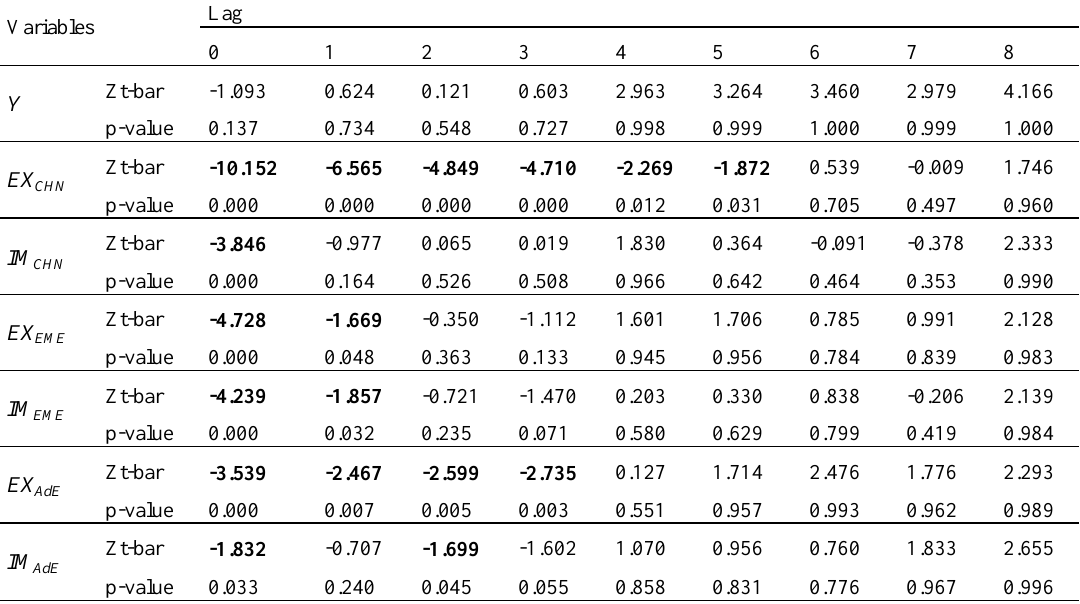
Table 2 : Pesaran (2007) unit root tests (with